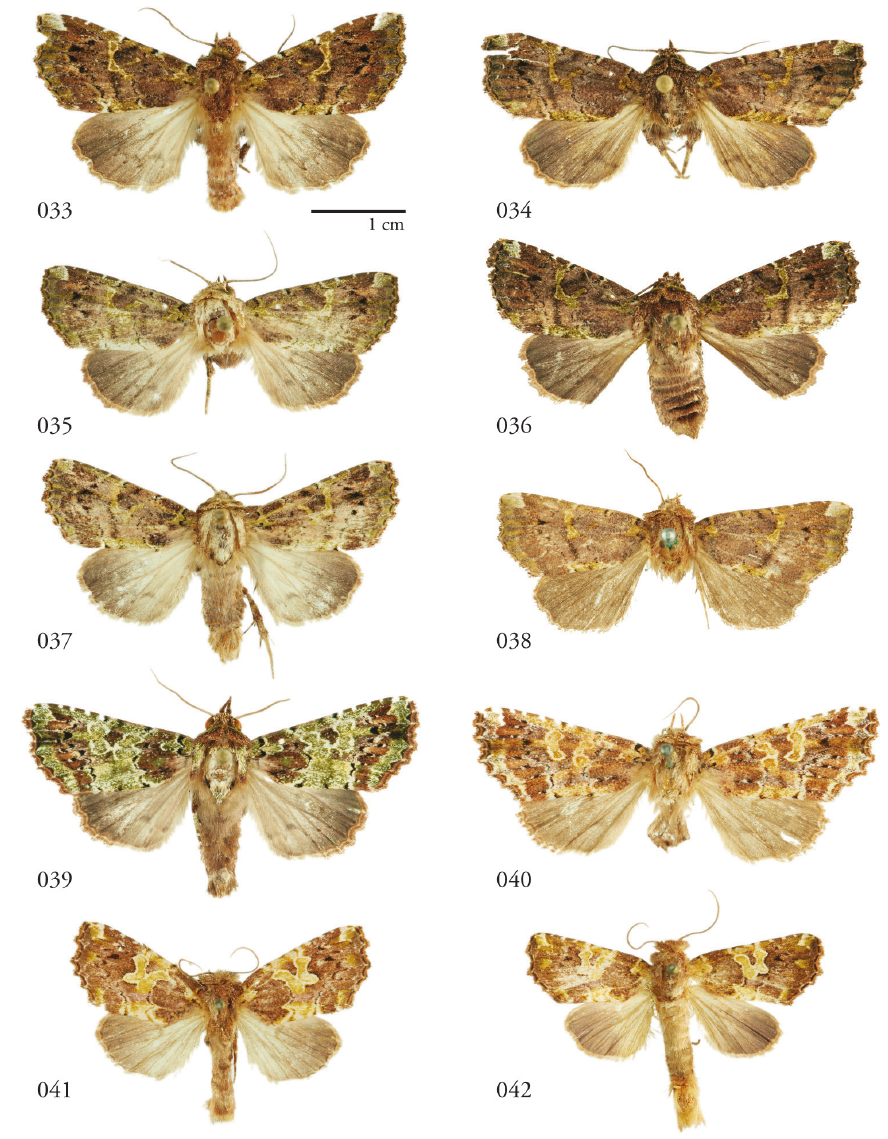
Figures 33–42. Leucosigma dorsal habitus. 33 L. sp. nr. schausi, ♂ , Dominican Republic, USN- MENT01370285, USNM Dissection 148142 34 L. sp. nr. schausi, ♀ , Área de Conservación Guan- acaste (ACG), Costa Rica, 11-SRNP-44977, USNMENT01370288, USNM Dissection 148079 35 L. schausi Holotype ♂ , ACG, 10-SRNP-72230, USNMENT01370303, USNM Dissection 148076 36 L. schausi ♀ , ACG, 10-SRNP-70113, USNMENT01370292 37 L. schausi ♂ , Costa Rica, USN- MENT01370291, USNM Dissection 148146 38 L. schausi ♀ , Cuba, genitalia Slide USNM Noc 4092, USNMENT01370281 39 L. albimixta ♂ , ACG, 10-SRNP-104564, USNMENT01370298 40 L. al- bimixta Holotype ♀ , Costa Rica, USNMENT01370283, USNM Dissection 148184 41 L. viridipicta ♂ , Peru, NHMUK010606202 42 L. viridipicta Holotype ♂ , French Guiana, USNMENT 00973419, USNM Dissection